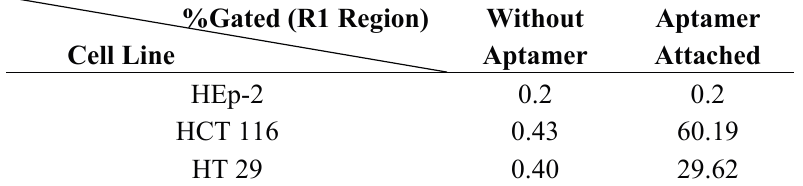
Figure 6. Flow cytometry histograms. ( a , b ) Epithelial cell line (HEp-2); ( c , d ) Epithelial cell line HCT 116 and ( e , f ) Epithelial-like cell line HT 29, before and after binding with aptamer are demonstrated. Experiments were repeated three times. Table 1. Results of binding between HEp-2, HCT 116 and HT 29 and modified KCHA10a